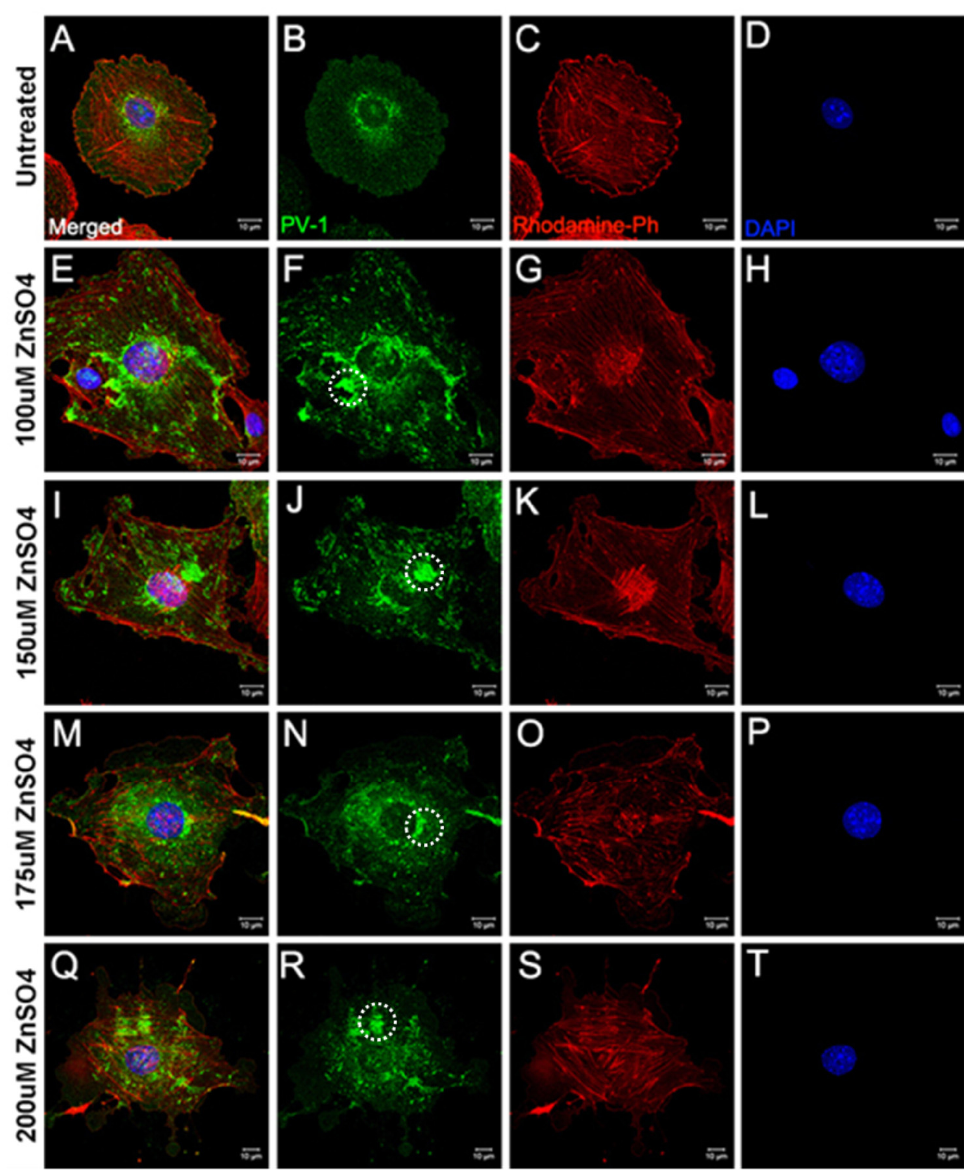
Figure 2. Sieve plate formation induced by zinc sulfate. 100–200 µ M of ZnSO 4 induced PV-1 redistribution (green) and sieve plate formation ( F , J , N , R ), examples indicated by white dotted circles) compared to untreated control cells ( B ). However, there were no significant actin (red) cytoskeletal changes ( C , G , K , O , S ) or degradation of the nucleus (blue) ( D , H , L , P , T ). ( A , E , I , M , Q ) show the images after merging the different fluorescence